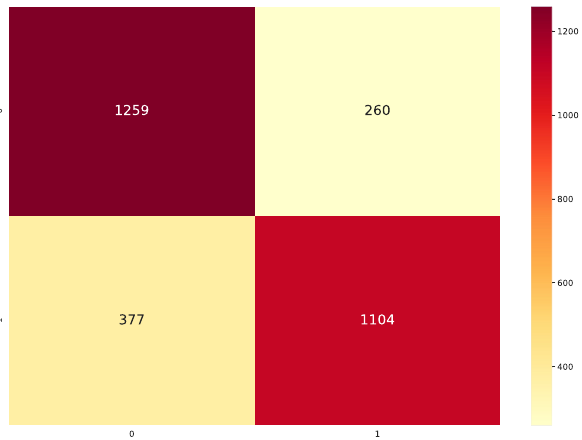
Figure 11: Confusion matrix made with the test dataset produced by the CNN with binary